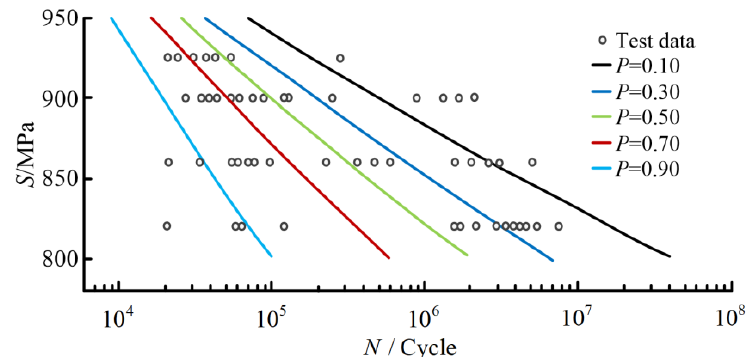
Table 2. P-S-N parameters of Ti-6246